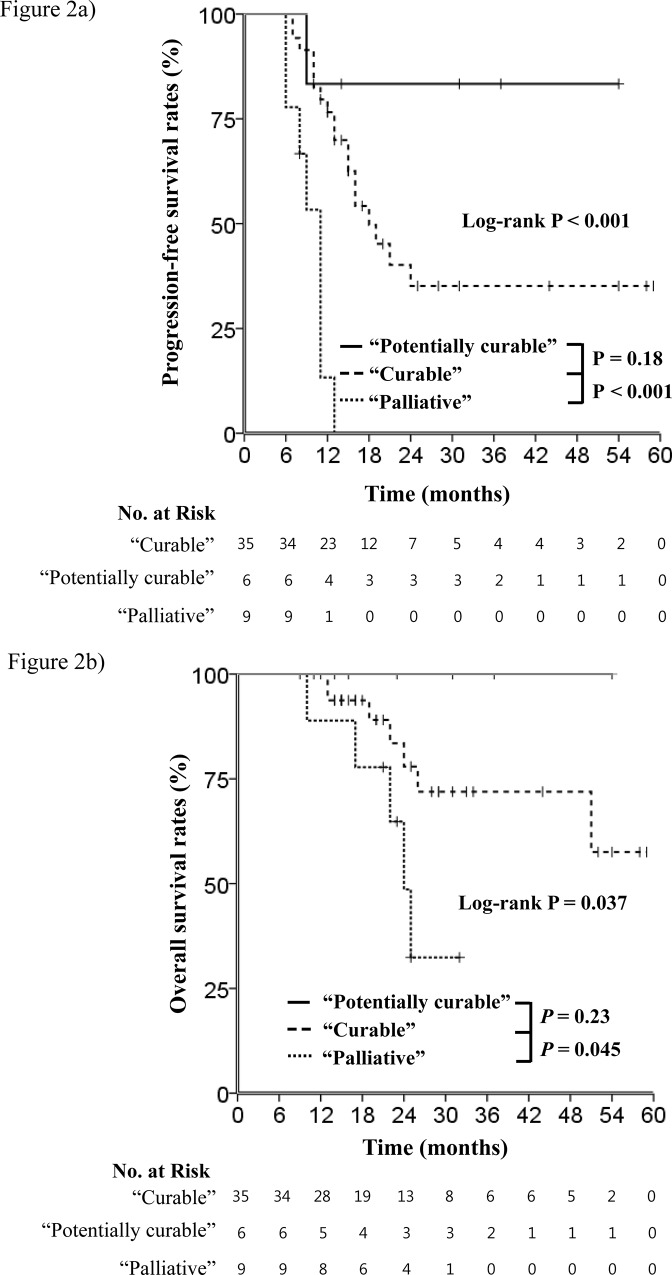
Kaplan-Meier curves according to treatment groups.(a) The progression-free survival rates of the curable (broken line) and potentially curable (line) groups were significantly longer than that of the palliative group (dotted line). (b) The curable (broken line) and potentially curable (line) groups showed longer overall survival than the palliative group (dotted line).